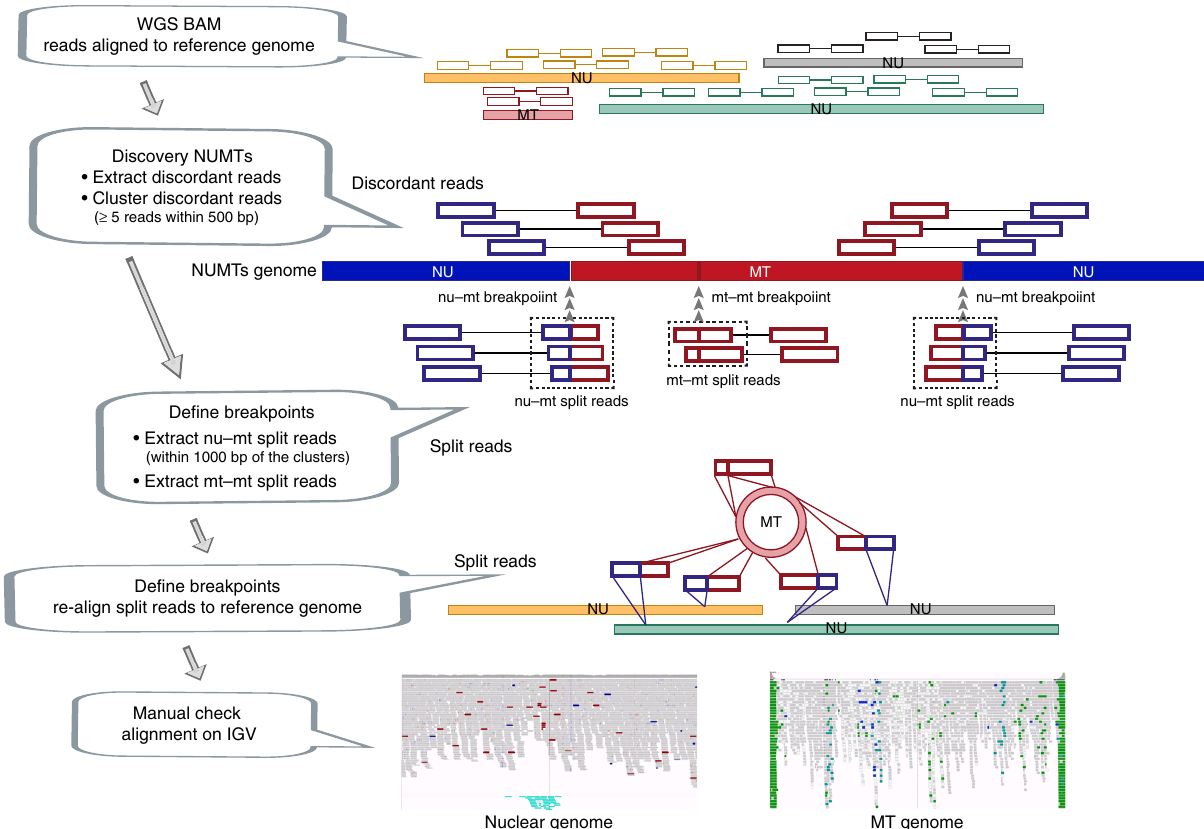
Fig. 3 Strategy for NUMT detection. NU – nuclear genome, MT – mitochondrial genome. nu-mt split reads: one end of the split read maps to nuclear DNA and the other end maps to mtDNA-derived sequence. mt-mt split reads: two ends of the same split read map to two locations on the mtDNA-derived sequences. nu-mt breakpoint: the breakpoint between joined nuclear and mtDNA-derived sequences. mt-mt breakpoint: the breakpoint joint two separate mtDNA-derived sequences. For a detailed explanation see